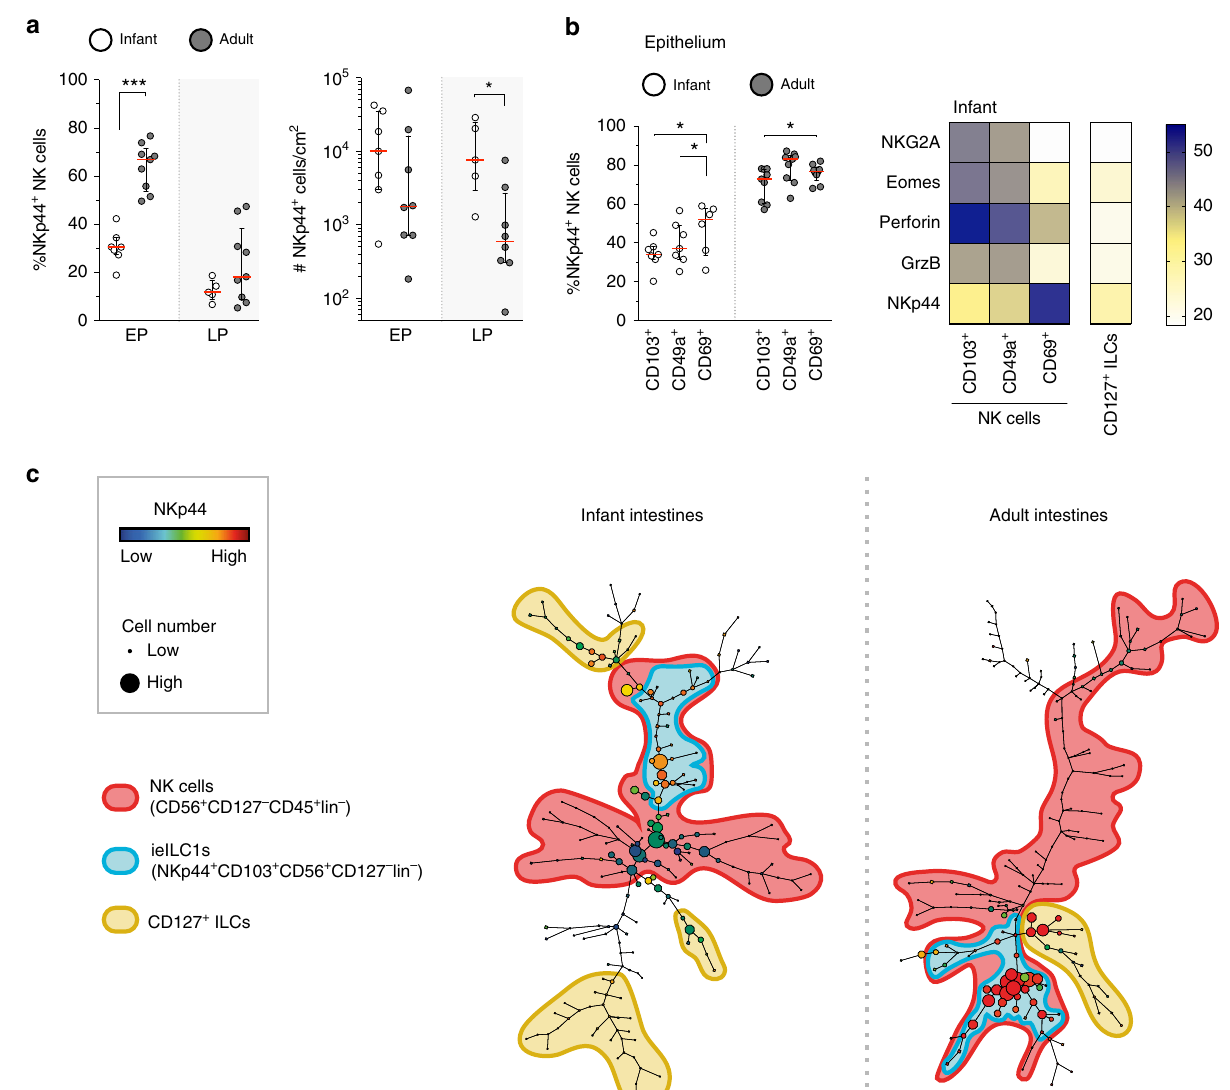
Fig. 7 Epithelial CD103 + NKp44 + lin − cells are the major ILC population in adults. a Frequencies as well as absolute cell numbers per cm 2 of epithelial (EP) and lamina propria-derived (LP) NKp44 + NK cells in infant (white circles) and adult (dark circles) intestines (infant NK cell frequencies and absolute counts EP ( N = 7) and LP ( N = 5), adult NK cell frequencies ( N = 9) and absolute counts ( N = 8)). b Frequencies of NKp44 + cells within CD103 + , CD49a + , or CD69 + NK cells in infants (white circles) and adults (dark circles). NKp44 expression by infant epithelial CD103 + ( N = 7), CD49a + ( N = 7), and CD69 + ( N = 6) NK cells. NKp44 expression by adult epithelial NK cell subsets ( N = 9). Heatmap of median frequencies of NKG2A + , Eomes + , perforin + , granzyme B + , and NKp44 + cells within CD103 + , CD49a + , or CD69 + NK cells as well as CD127 + ILCs in infant intestines. c SPADE tree of viable EP CD45 + lin − lymphocytes. CD127 + ILCs (yellow outline), NK cells (red outline), including CD127 − NKp44 + CD103 + lin − cells (blue outline) within NK cell population. Expression of NKp44 is shown by color coding in relative intensity. Node sizes represent the size of populations. SPADE analysis was computed by using the same signature parameters as in Fig. 1 (infant samples N = 4, adult samples N = 5, target number of nodes: 200, down sampled events target: 30%). Median frequencies indicated by red lines. Error bars de fi ne interquartile ranges between 75th and 25th percentiles. Statistical comparisons are Mann-Whitney U comparisons ( a ) and Wilcoxon matched-pairs signed rank tests ( b ). Asterisks represent the following p -values: * p < 0.05 and *** p <